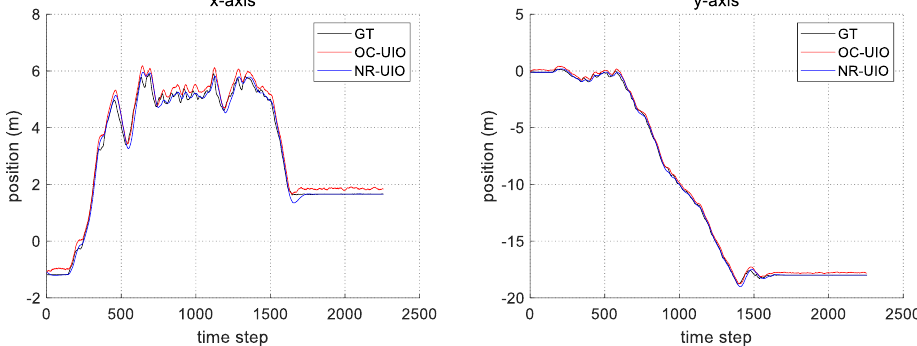
Figure 10. The overall trajectories estimated with the SOTA offset compensated UWB-Inertial odometry (OC-UIO) and the proposed NLOS-robust UWB-Inertial odometry (NR-UIO).